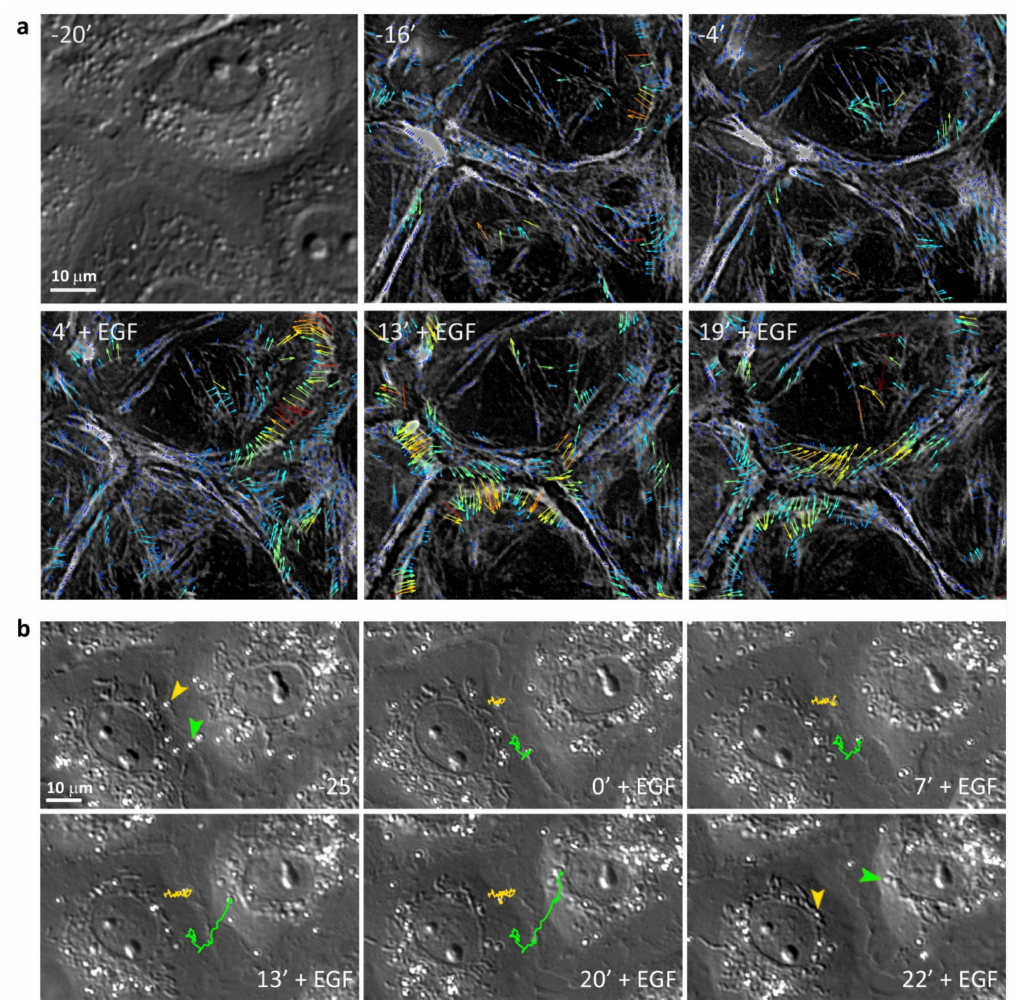
Figure 5. Retrograde flow in IAR-20 cells caused by addition of EGF. ( a ) Myosin retrograde flow in GFP-RLC expressing IAR-20 cells treated with EGF. Selected frames from Video S4. “-20’”–a corresponding DIC image to illustrate the integrity of the control monolayer. Myosin “speckles” were tracked using qFSM plugin for MatLab. In control cells, the slow speckle movement is only observed along the AJs. Immediately after EGF addition, the speckles begin to move centripetally, at much faster speeds. ( b ) Tracks of migrating ConA beads attached to the dorsal cell surface in the zone of cell-cell contact before and after the addition of EGF. Selected frames from Video S5. Arrowheads indicate initial and final positions of the